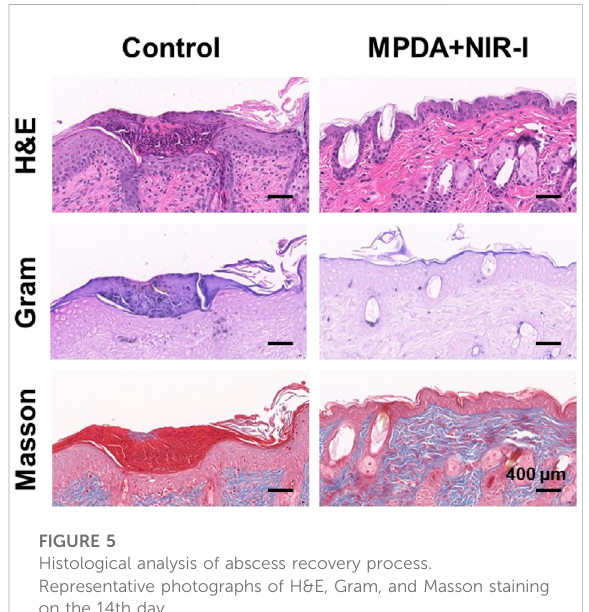
Histological analysis of abscess recovery process. Representative photographs of H&E, Gram, and Masson staining on the 14th